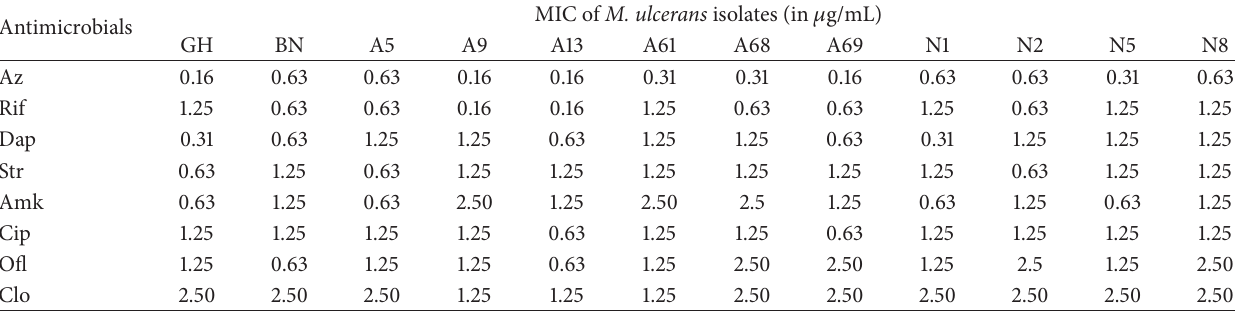
Table 1: Minimum inhibitory concentration ( 𝜇 g/mL) of the antimicrobials. Antimicrobials